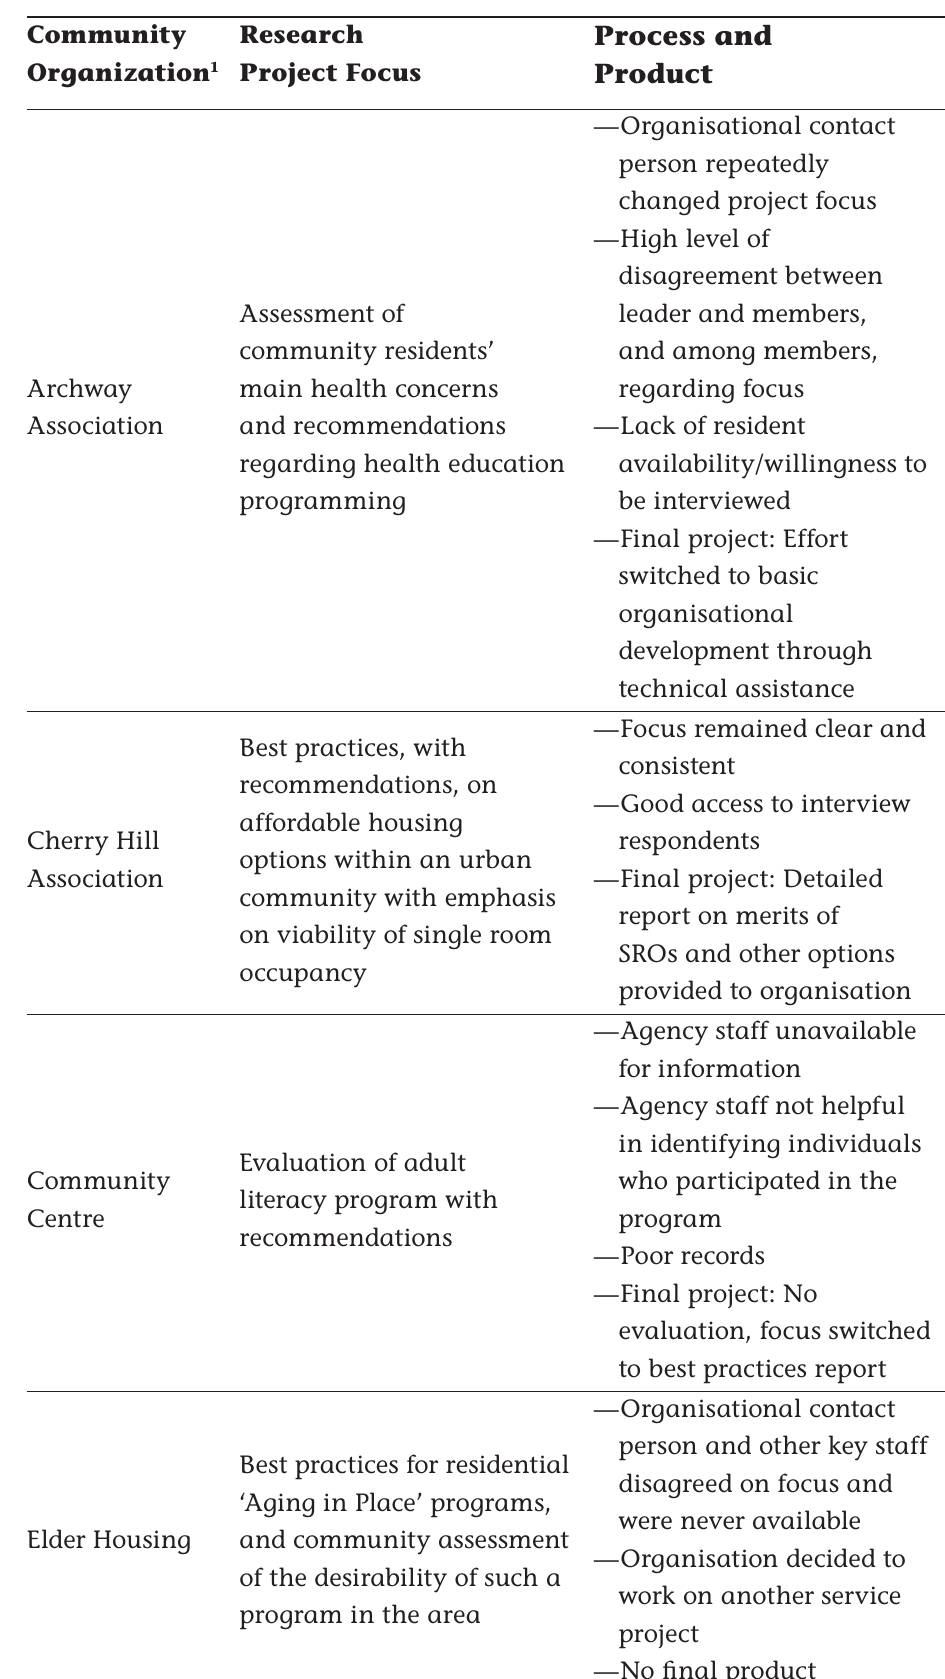
Table 1: Community Organisations in Research Collaboration Projects 1 Organisation names changed for purposes of